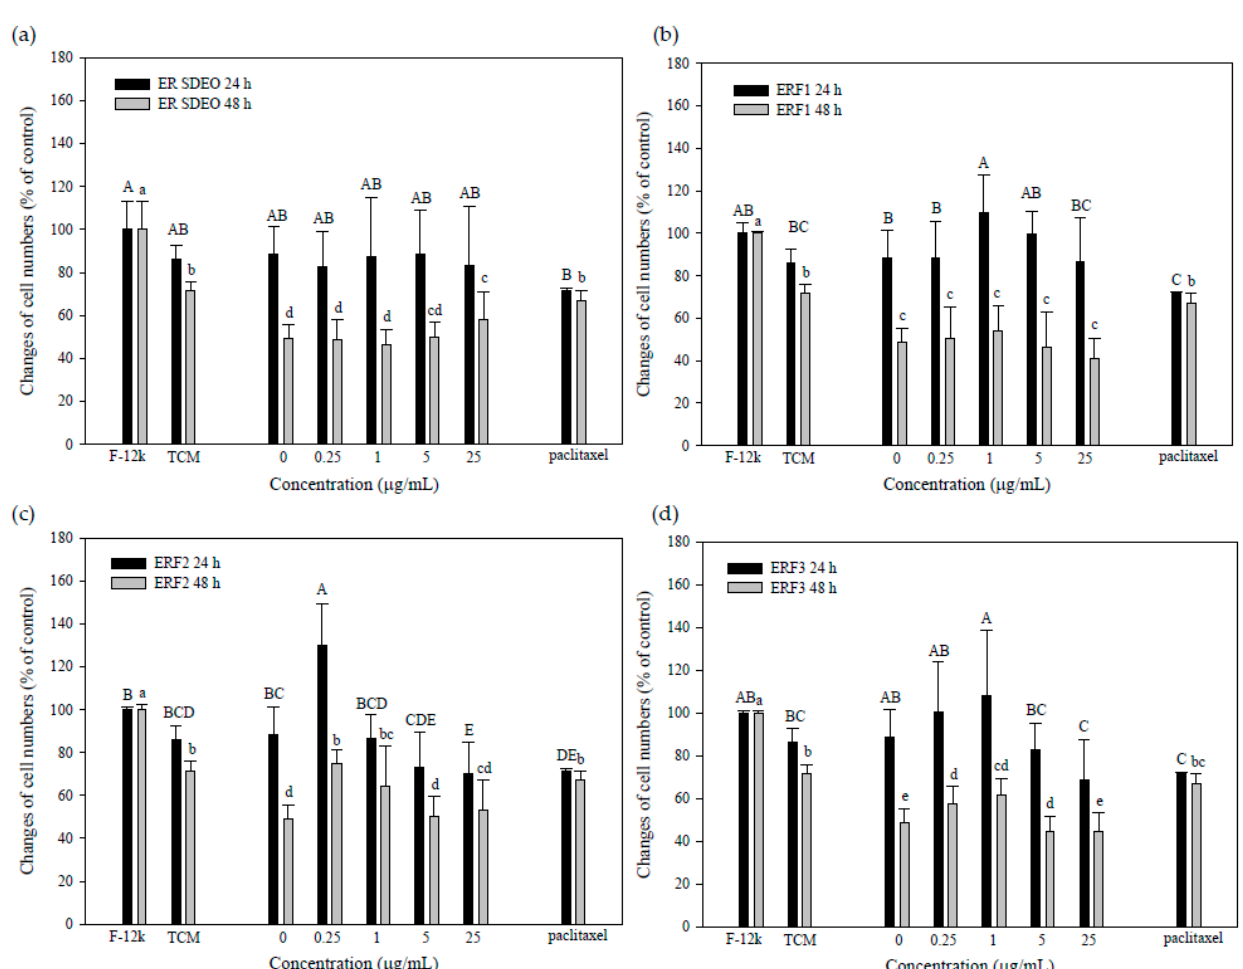
Figure 6. Effects of MCM prepared in the absence or presence ER SDEO ( a ), ERF1 ( b ), ERF2 ( c ), and ERF3 ( d ) on PC-3 cell growth. Cells (1 × 10 6 cells/mL) were treated with MCM for 24 and 48 h, respectively. Values are mean ± SD ( n = 6 biological determinations). Bars in the same plot at the same incubation time not sharing a common letter are significantly different ( p < 0.05) from each other assayed by one-way ANOVA, followed by Duncan’s multiple range test. MCM, macrophage-conditioned medium. PC, positive control (paclitaxel at 2.5 μΜ ).